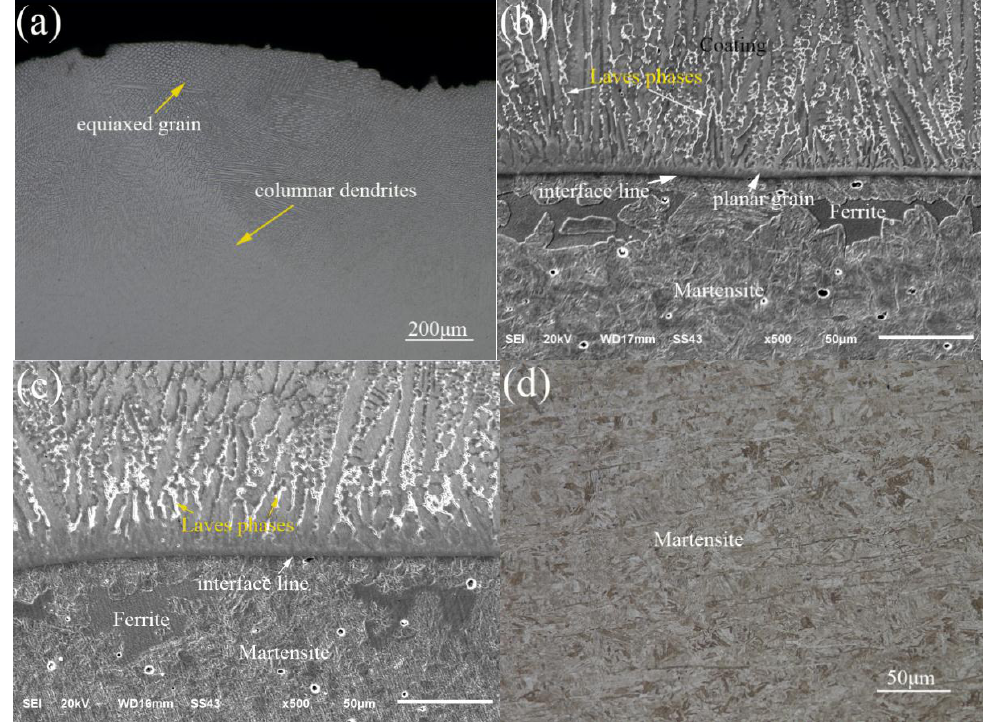
Figure 3. The dendritic morphology ( a ) and SEM microstructures at interface area of the substrate and coating material of monolayer ( b ) and trilayer ( c ) coatings, ( d ) microstructure of the substrate.